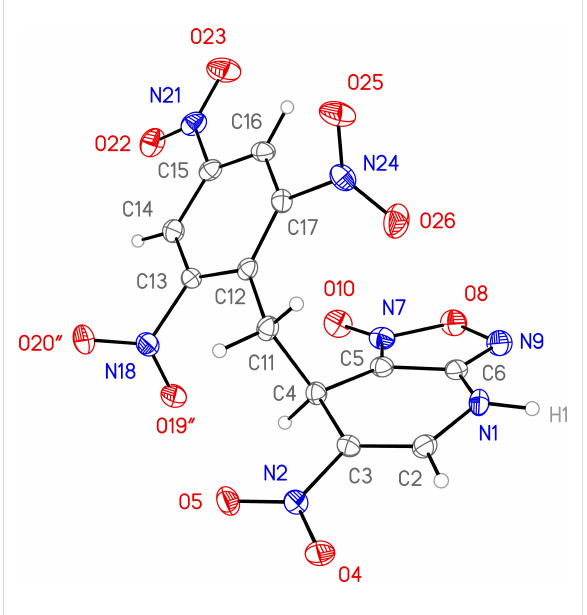
Figure 3: General view of molecule 15 in crystal. Anisotropic displace- ment parameters for non-hydrogen atoms are drawn at 50% probabili- ty; a DMSO molecule and the minor component of the disordered nitro group (N18 O19” O20”) is omitted for